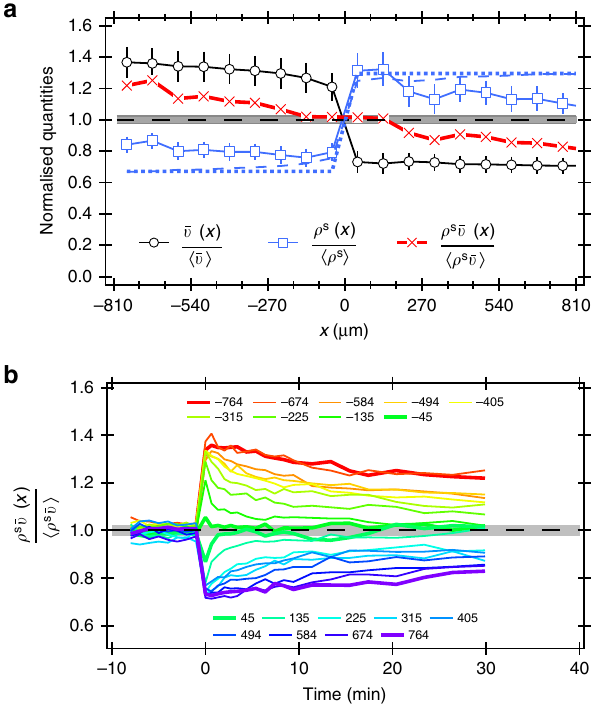
Fig. 2 Response of AD10 at OD = 5.3 to a stepped intensity pattern. a Normalised quantities as indicated vs. x after ≈ 30 min of stepped illumination, and predictions for normalised ρ s based on two speeds (dotted line) and complete measured (cid:1) v ð x Þ pro fi le (dashed line). Error bars are s.e.m. of the y -averaged values. b Time dependence of normalised ρ s (cid:1) v at various